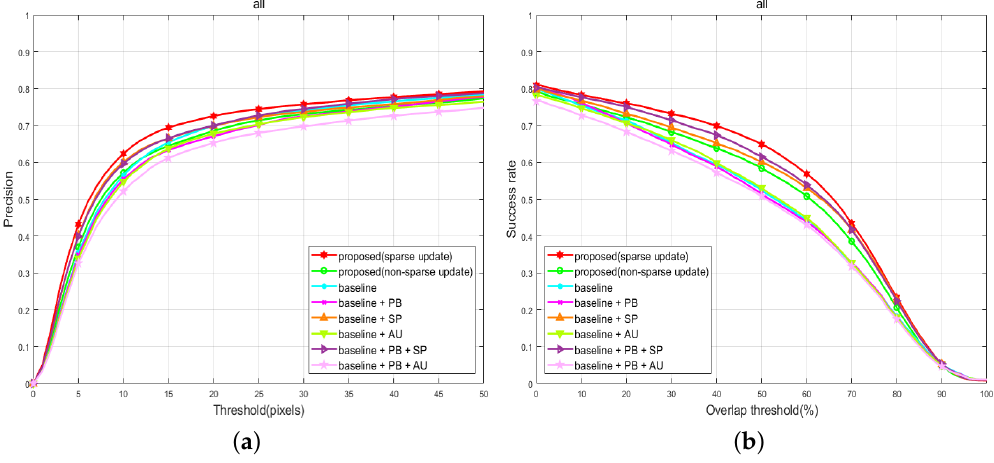
Figure 6. The precision plots and success plots over all 100 sequences for each combination. ( a ) precision plots; ( b ) success